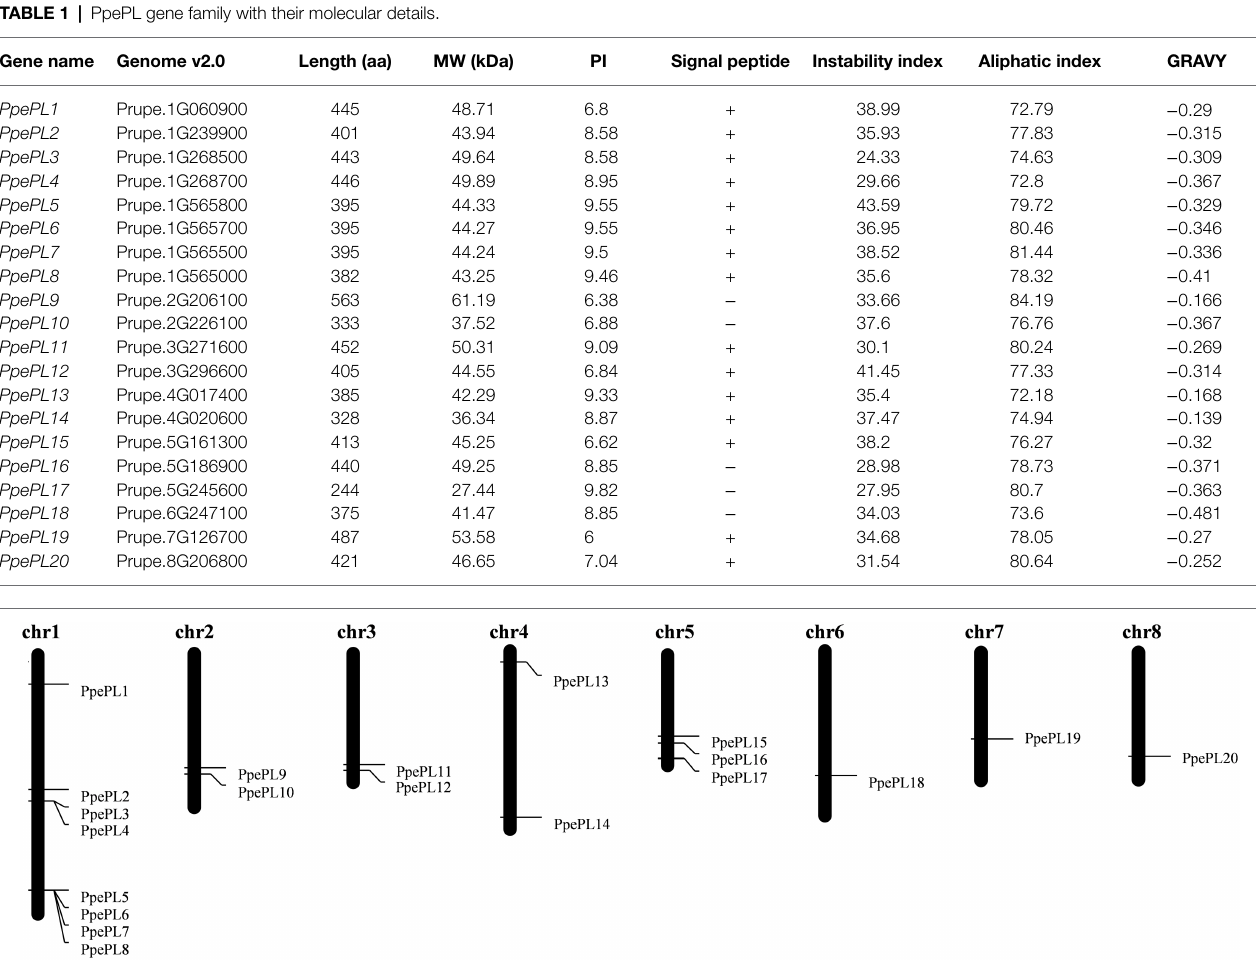
FIGURE 1 | Chromosomal mapping of PpePL genes. chr: chromosomal.